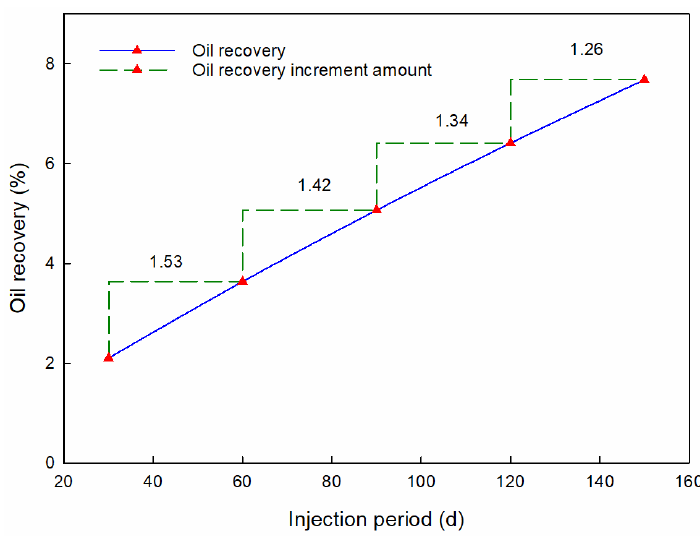
Figure 6. Oil recovery with different injection periods.